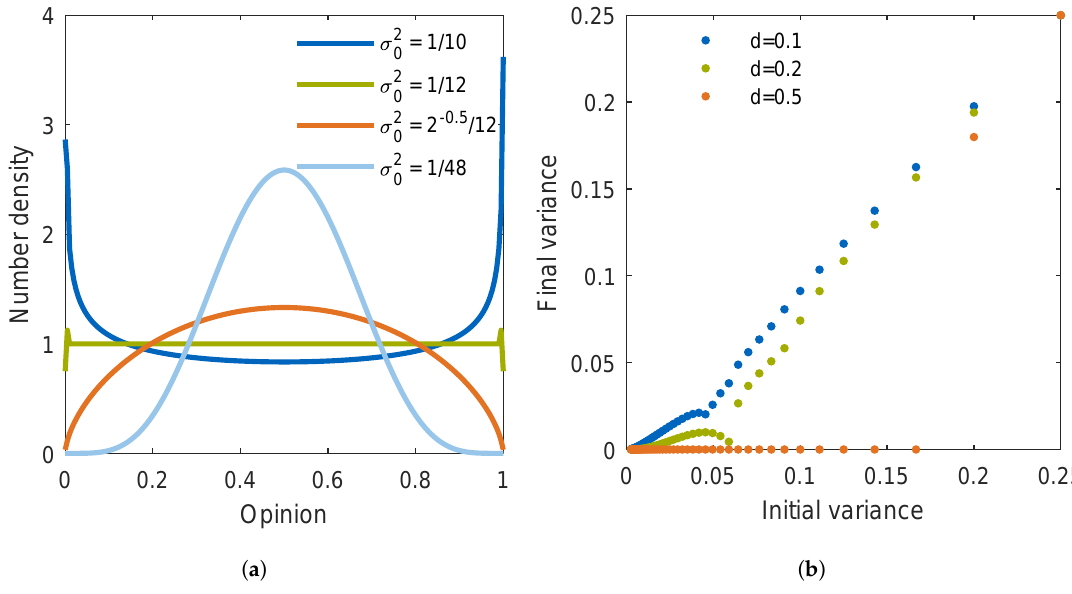
Figure 4. Variation of initial distribution; used initial distributions with mean value ¯ x 0 = 0.5 and several values of variance σ 2 ( a ); estimated steady state variance over initial variance for three different 0 values of the bounded confidence parameter d ( b ).